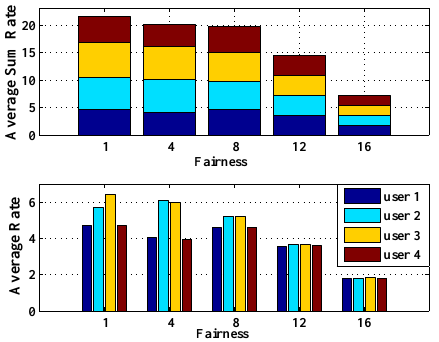
Figure 1: (Top) Average sum rate of all SUs, (Bot- tom) Average rate of each